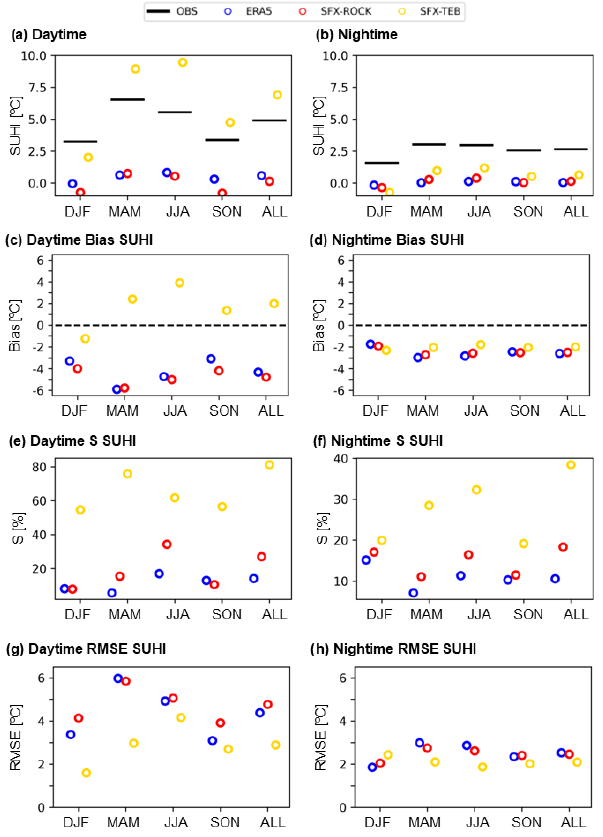
Figure 7. Annual and seasonal average Parisian SUHI magnitude computed over the 2004–2018 period during the (a) daytime and (b) nighttime. The corresponding annual and seasonal average bias for the daytime is represented in panel (c) and for the nighttime in panel (d) . The corresponding annual and seasonal S score is rep- resented in panel (e) for the daytime and panel (f) for the night- time. The corresponding annual and seasonal RMSE is represented in panel (g) for the daytime and panel (h) for the nighttime. The LSA-SAF is represented by black lines, ERA5 by blue markers, SFX-ROCK by red markers, and SFX-TEB by yellow markers.